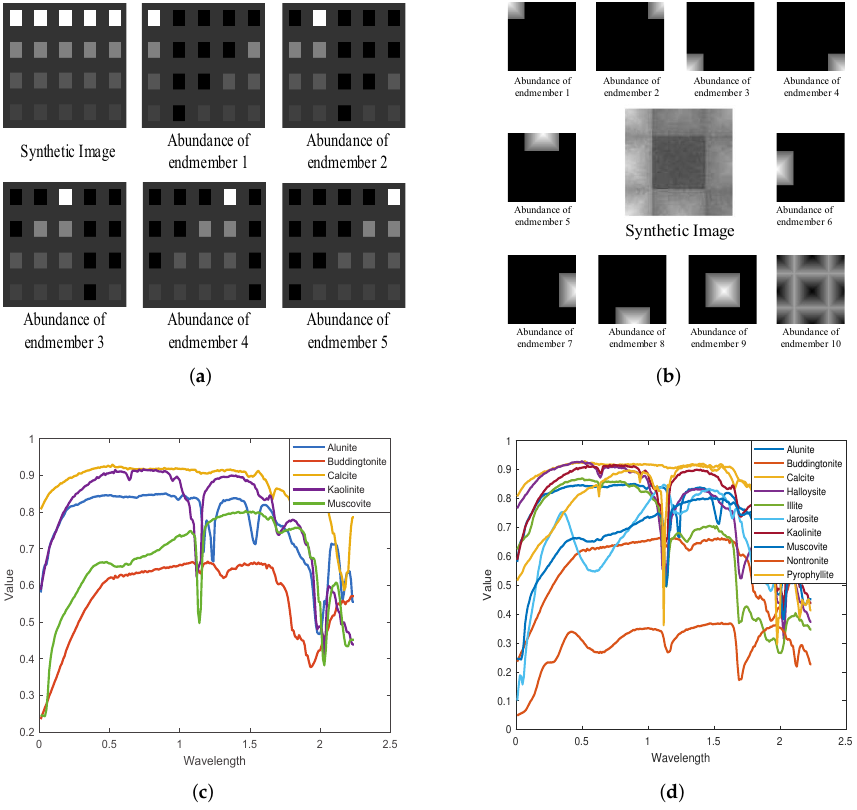
Figure 3. Simulated data sets. ( a ) The image and the abundance of 5 endmembers of DS1. ( b ) The image and the abundance of 10 endmembers of DS2. ( c ) Five spectra in DS1. ( d ) Ten spectra in DS2.